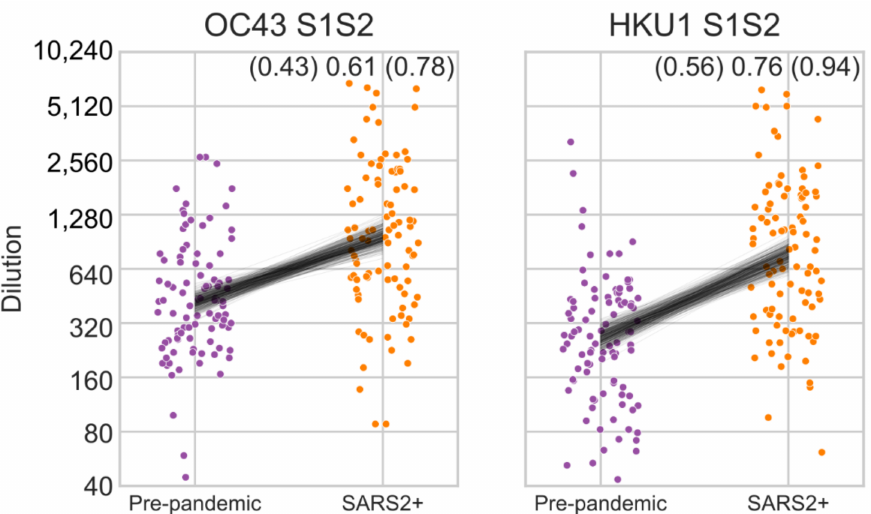
Figure 5. Inflection titers of pre-pandemic and SARS-CoV-2 PCR positive human sera (SARS2+) to beta-HCoV S1S2 proteins. Black lines show the posterior distribution of differences in group means inferred from a linear model using Student-T distributed error. The upper and lower boundaries and mean of the 95% highest posterior density interval of difference in group means is shown in the top right; 1 unit is a single 4-fold